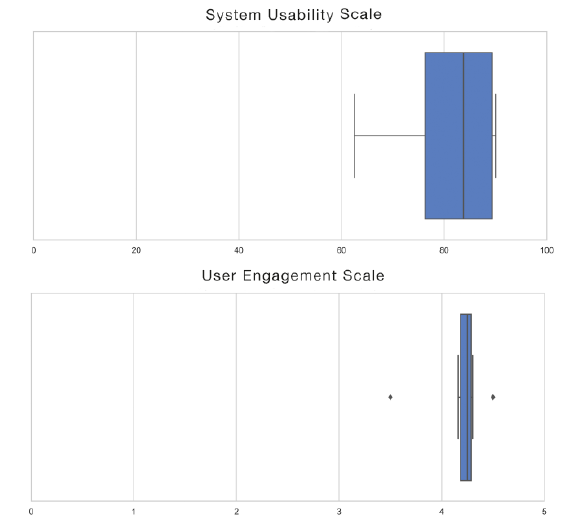
Figure 5. Participants ranked the prototype as usable and engaging. Top: Outcome of the SUS (in percent). Bottom: Outcome of the UES-SF (Likert scale